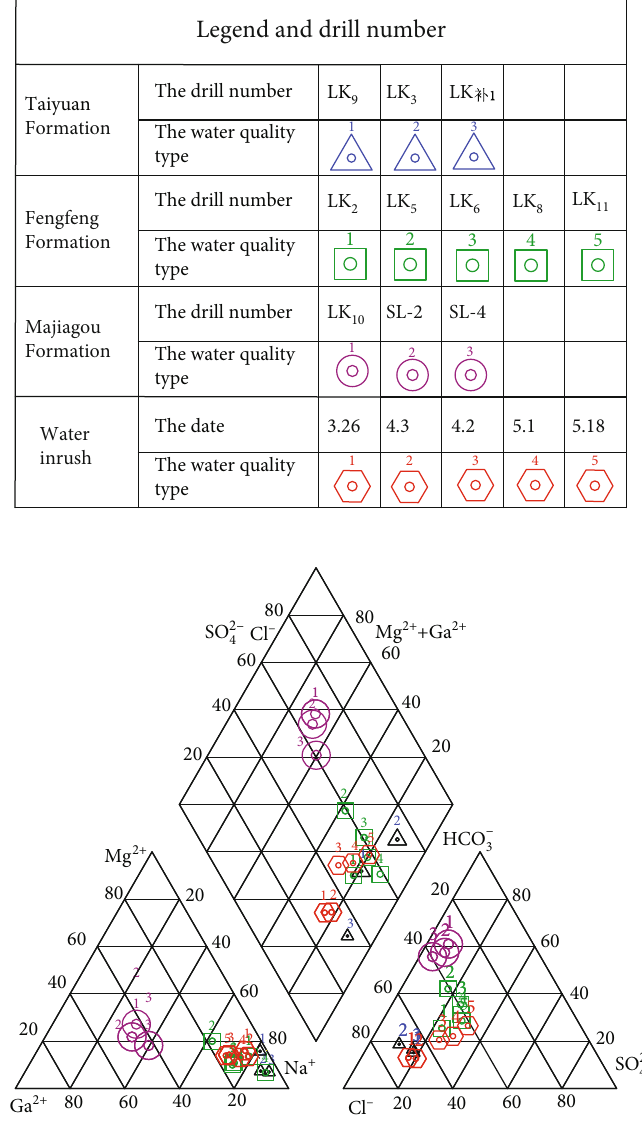
Figure 7: Hydrochemical classi fi cation of three